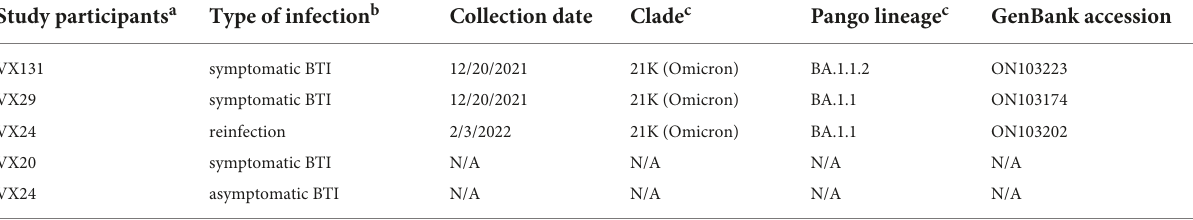
TABLE 2 Severe acute respiratory syndrome coronavirus 2 (SARS-CoV-2) variants confirmed by whole genome sequencing. Study participants